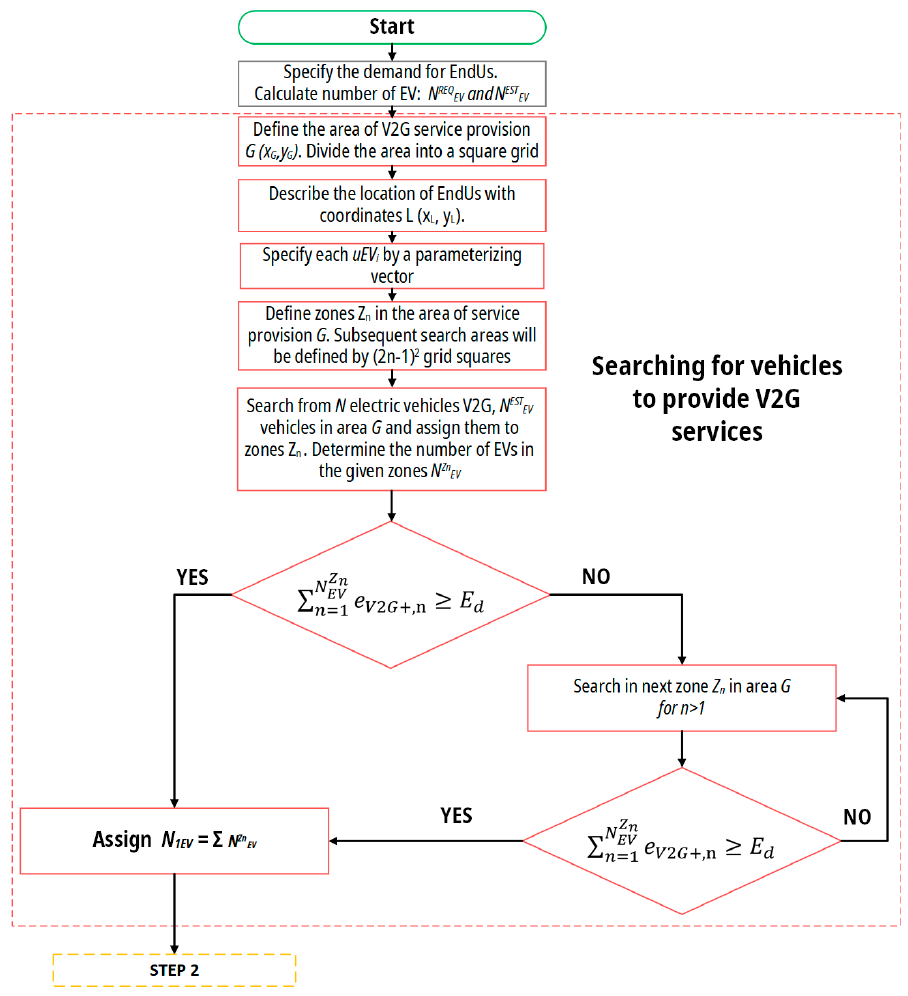
Figure 5. First part of proposed algorithm - searching for vehicles to provide V2G services.